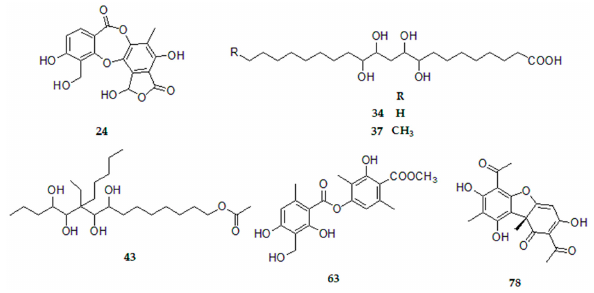
Figure 5. Chemical structures of similar compounds in U. antarctica , U. barbata , U. subfloridana and U. rubicunda .